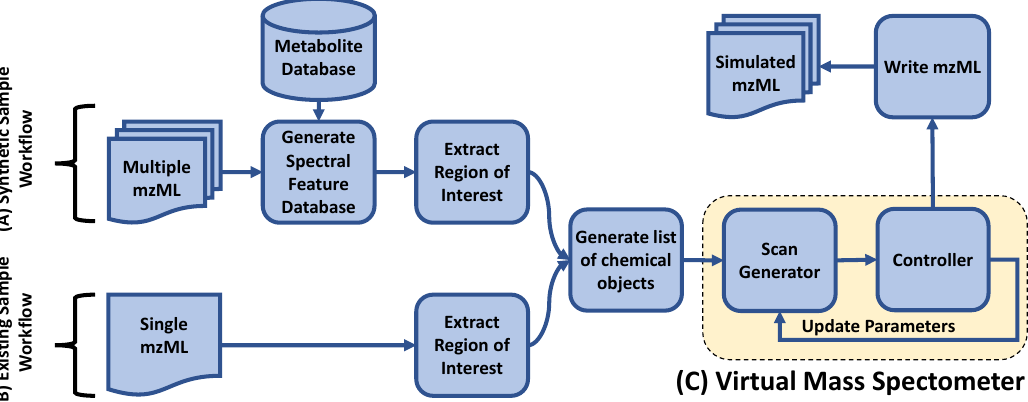
Figure 1. An overall schematic of ViMMS. ( A ) Synthetic Sample Workflow: Chemical objects in ViMMS can be created by sampling for compound formulae, mz, RT, and intensity values from the spectral feature database. ( B ) Existing Sample Workflow: alternatively, chemical objects can be created by extracting regions of interest from a single mzML file and converting them to chemical objects. ( C ) Yellow box: chemical objects are processed in the virtual mass spectrometer during in silico scan simulations. A controller performs parameter updates on the mass spectrometer depending on the fragmentation strategy implemented in the controller. Simulated results can be written as mzML